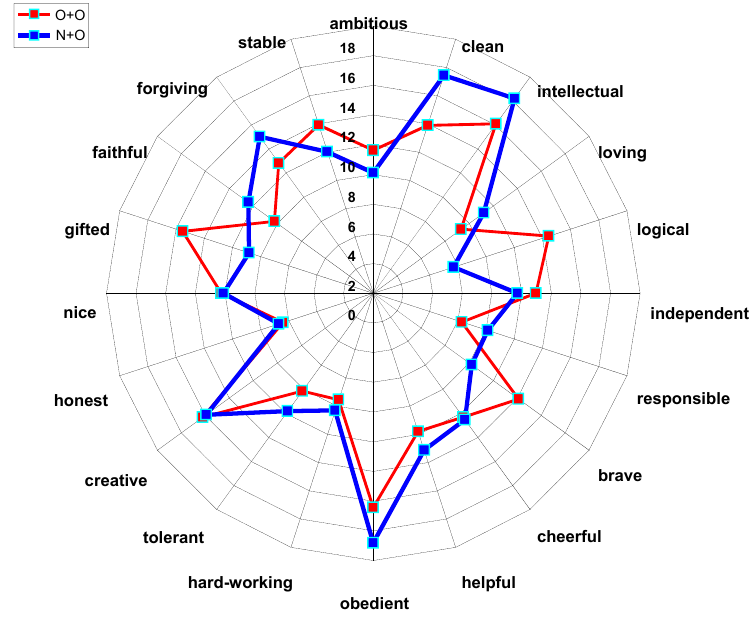
Figure 7. A list of terminal value preferences of Orthodox respondents and respondents not declaring any religion from Orthodox families. Source: own study based on research results.